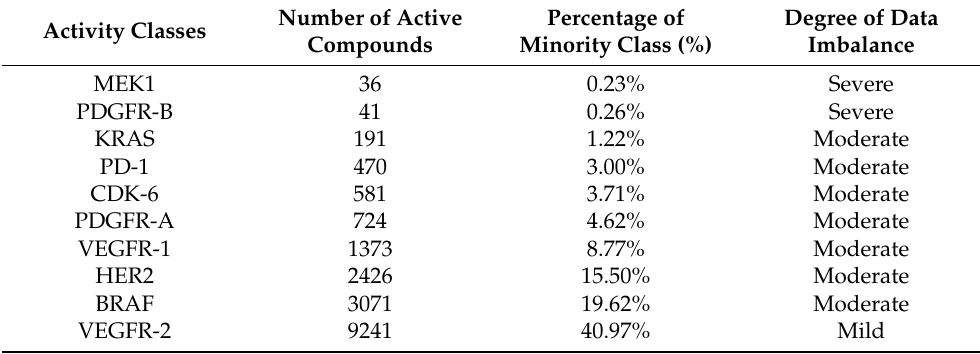
Table 2. The degree of imbalance and the percentage of minority class sorted by the number of active compounds per activity class.